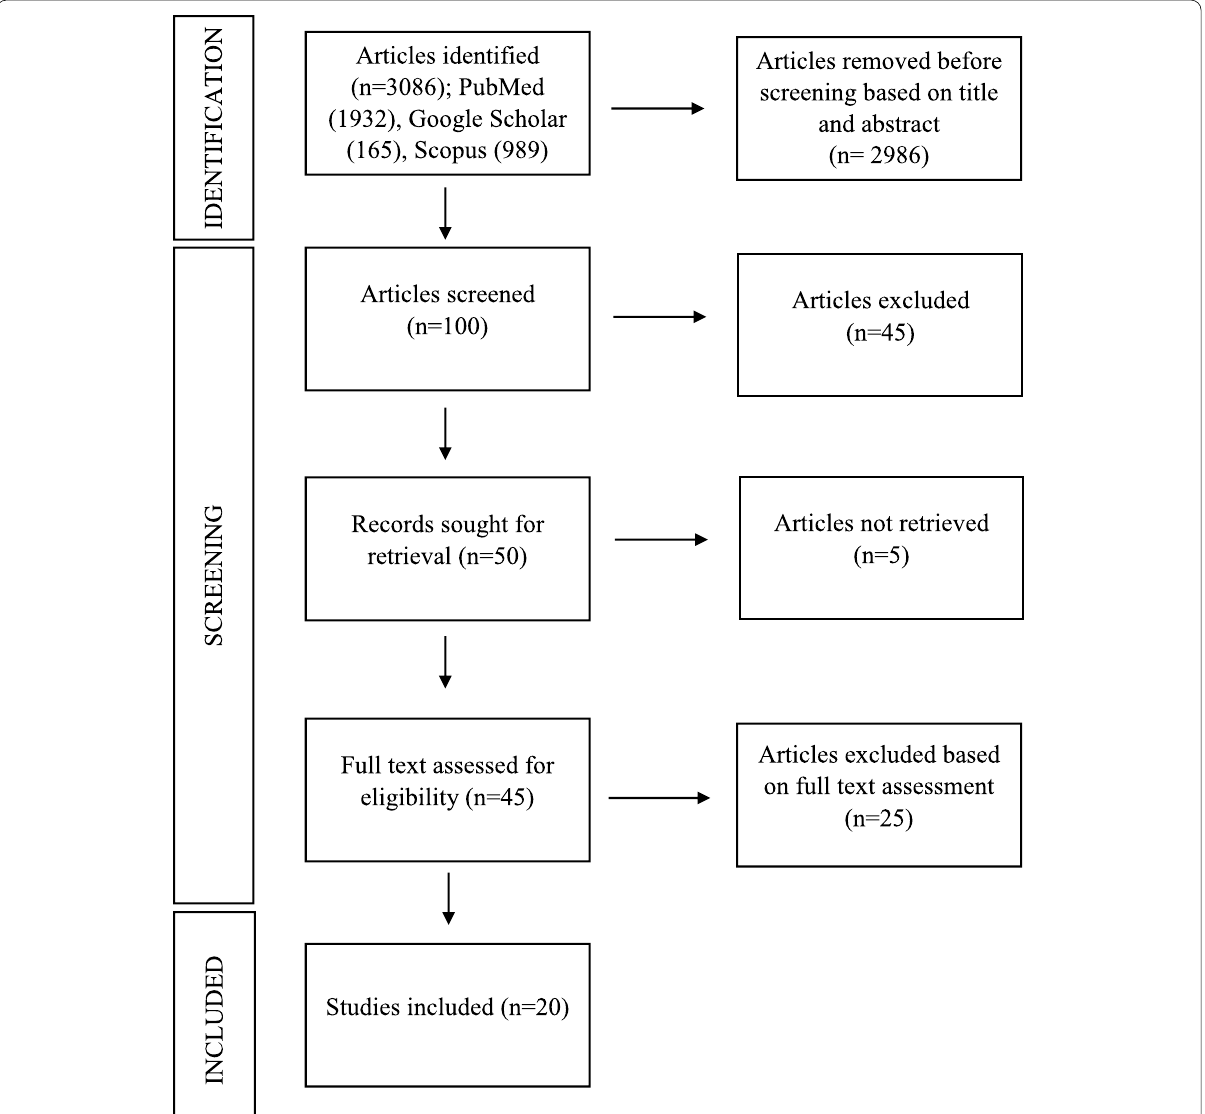
Fig. 1 Flowchart of the systematic review process on autopsy findings in COVID-19 deaths following PRISMA model. Footnote: ( n ) refers to